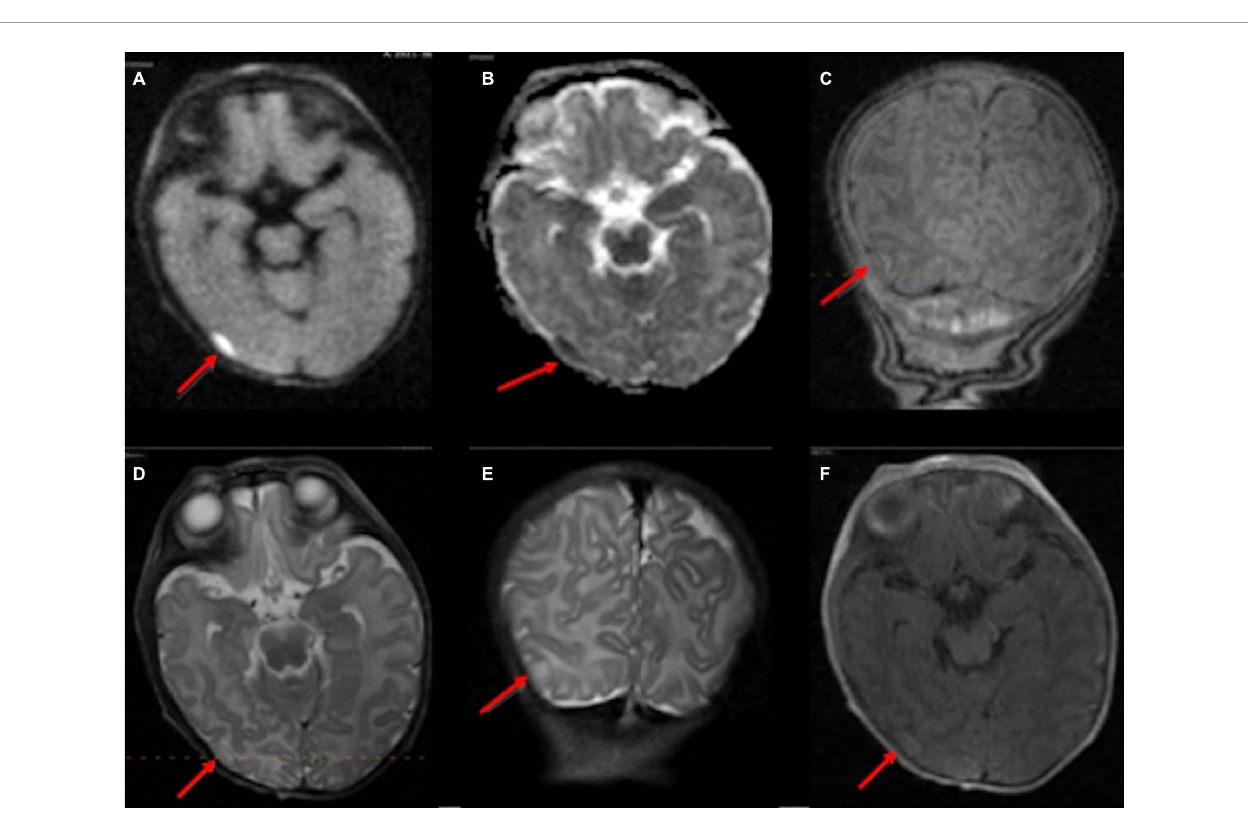
FIGURE8 In an 11-day-old term neonate with a history of decreased respiratory drive, the 1-Tesla point-of-care MRI showed a subdural collection overlying the right temporo-occipital junction with reduced diffusion on DWI (A) and ADC (B) , which appeared isointense on T1 (C,F) and T2 (D,E) . No other brain imaging was